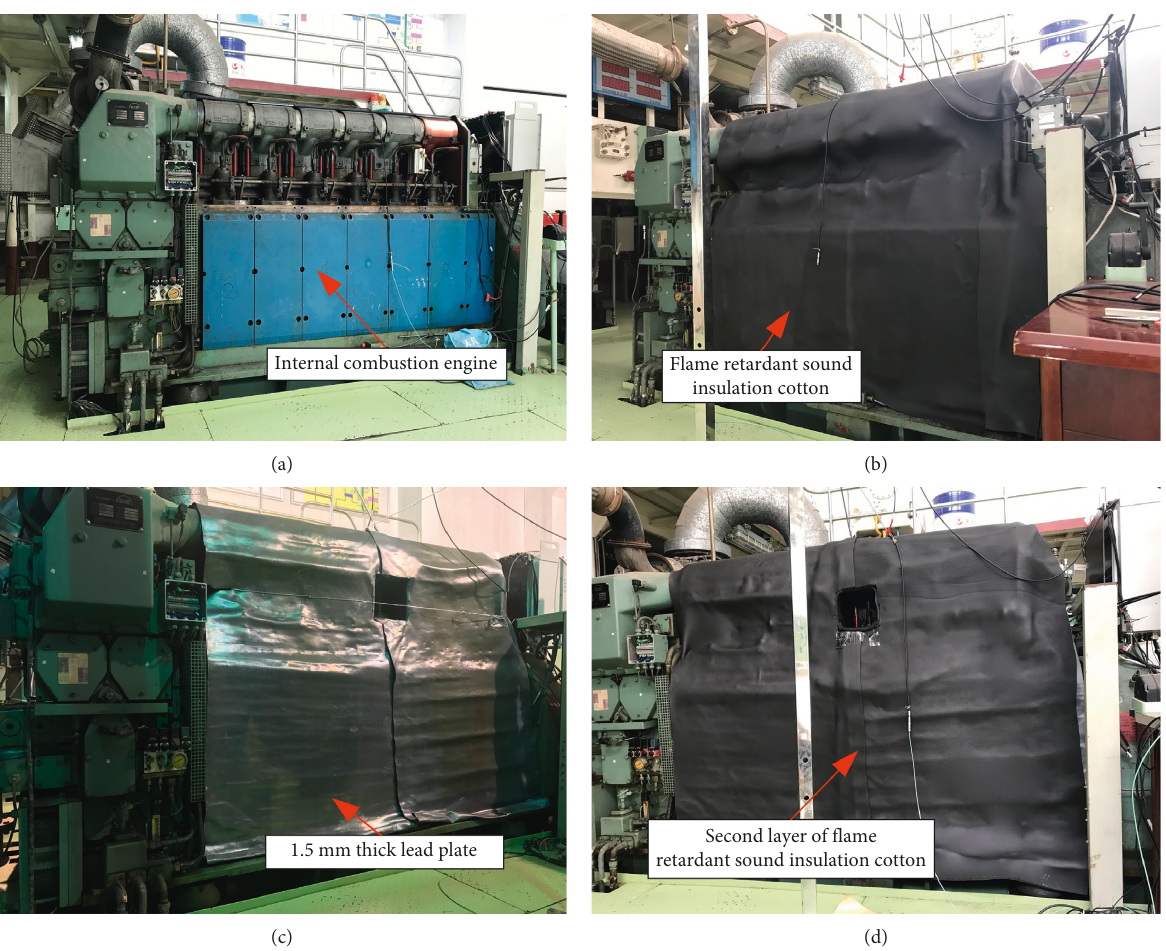
Figure 8: The lead coverage method. (a) Diesel engine. (b) The first layer of flame retardant sound insulation cotton. (c) The 1.5mm thick lead plate. (d) The second layer of flame retardant sound insulation